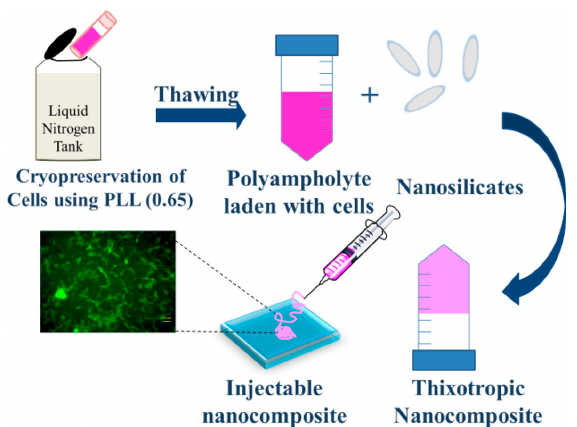
Figure 16. Schematic representation of thixotropic nanocomposite formation from poly- L -lysine and nanosilicates. Image adapted with permission from reference [40]. Copyright 2016 Elsevier.